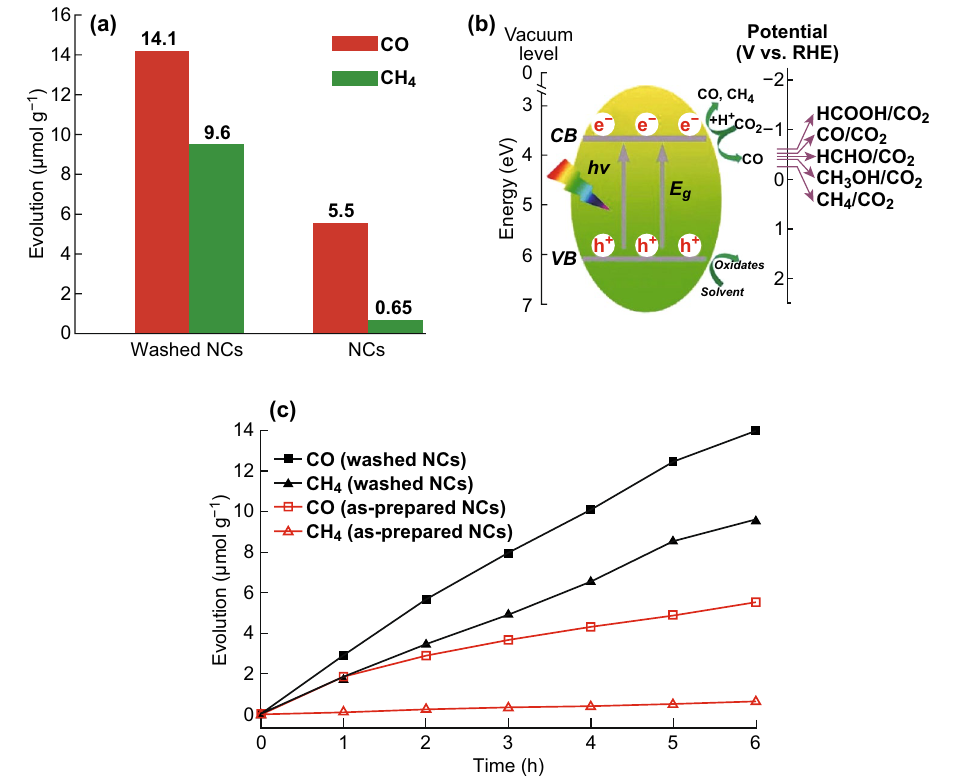
Fig. 6 a Comparison of photocatalytic CO 2 reduction performance of the as-prepared Cs 2 AgBiBr 6 NCs and washed NCs. b Schematic dia- gram of the photoreduction of CO 2 on the surface of Cs 2 AgBiBr 6 NCs. c Time course of CO and CH 4 evolutions over as-prepared and -washed Cs 2 AgBiBr 6 NCs. Reproduced with permission from Ref.